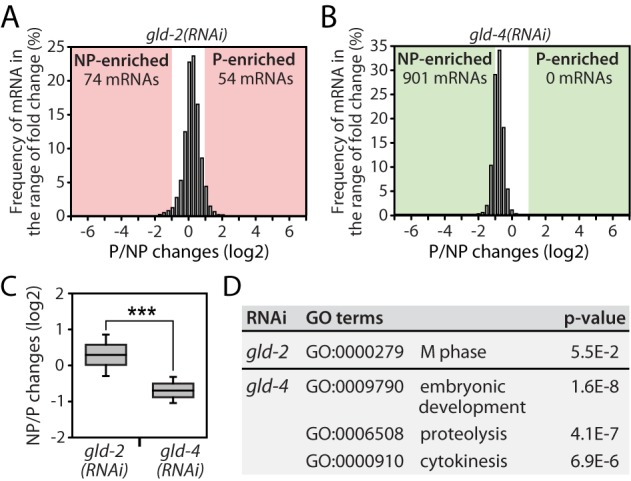
gld-4 promotes general translation. (A andB) Translational efficiency changes of all 7649 detectable genes in (A) gld-2(RNAi) and (B) gld-4(RNAi). (C) Statistical analysis of translational efficiency changes. (D) GO-term analysis of NP-enriched mRNAs in gld-2(RNAi) and gld-4(RNAi). Student's t-test: ***, P < 0.001.